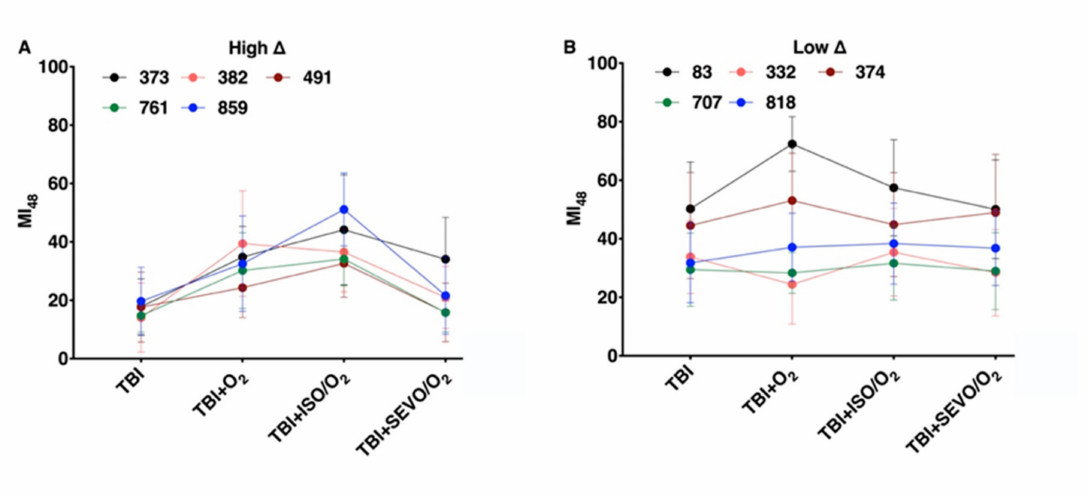
Figure A3. Individual MI 48 response trajectories for the ( A ) high and ( B ) low ∆ groups. The trend of each line follows that of the MI 24 graph. Exposure e ff ects are significant ( p < 0.001, one-way ANOVA). In the low ∆ group, drug e ff ects are significant only for RAL83 ( p = 0.0018, one-way ANOVA). Figures A4–A13 Raw data for locomotion experiments for each RAL line. Climbing results at 24 h and 48 h time points. Climbing impairment in Figures 4–8 represent the fraction of flies in the lower quartile (black section). For all figures, Control (no exposure) n = 54, TBI n = 54, ISO / O 2 n = 18, TBI + ISO / O 2 n = 18, SEVO / O 2 n = 24, TBI + SEVO / O 2 n = 24, O 2 n = 12, TBI + O 2 n =